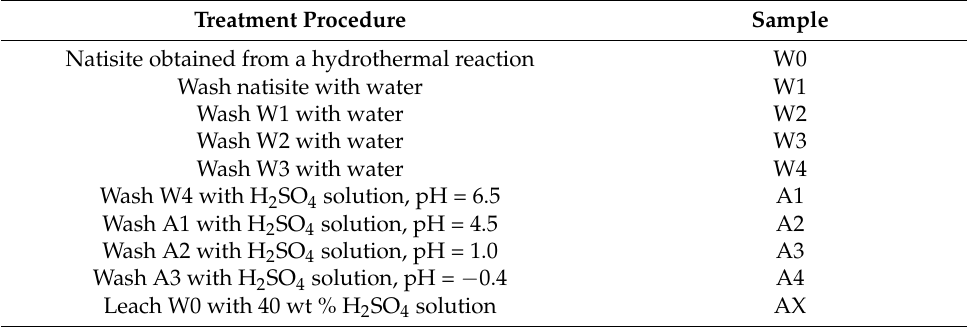
Table 1. Treatment procedures for natisite and names of the obtained solid